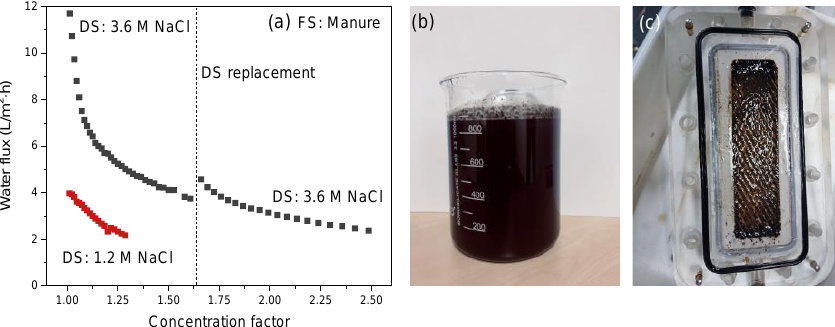
Figure 9. ( a ) Water flux as a function of the concentration factor using manure as FS. The intermission in the curve is due to the refreshing of the DS to reset it to 3.6 M NaCl; ( b ) Initial manure slurry; ( c ) Opened membrane cell after the manure concentration process.